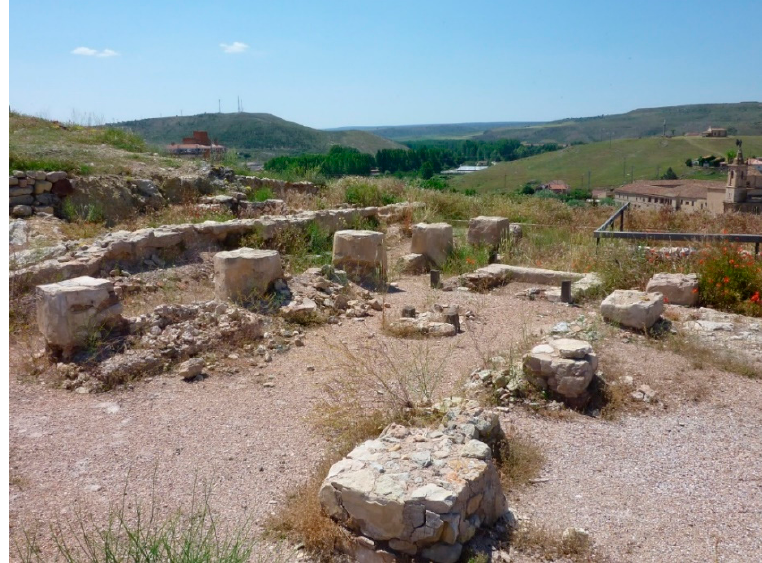
Figure 12. View of the remains of the tevah of Molina de Aragón Synagogue. Author’s photo.